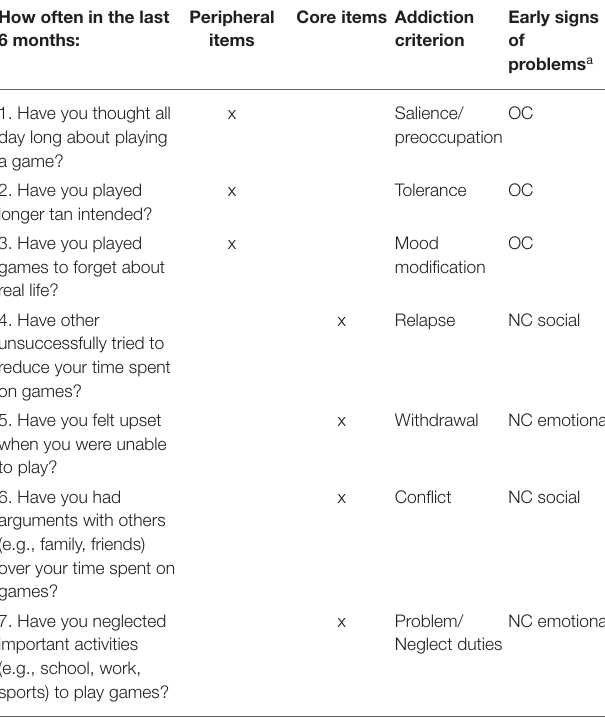
TABLE 2 | GASA, peripheral and core items corresponding to OC and NC,